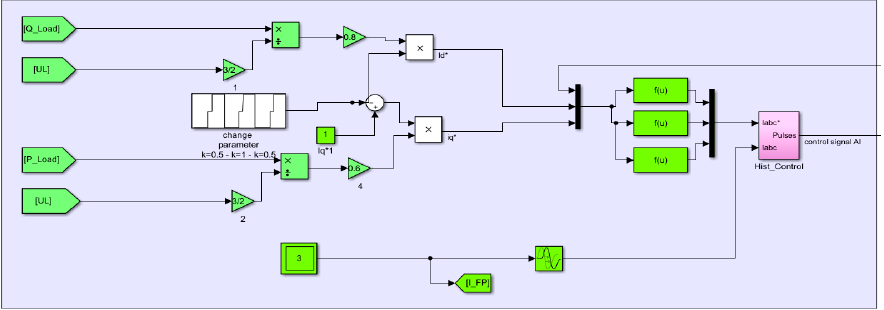
Figure 15. Simulation model of the AI control block.